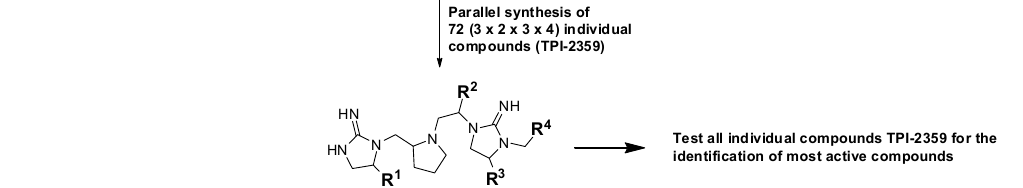
Figure 2. Deconvolution of positional scanning pyrrolidine bis ‐ cyclic guanidine library TPI ‐ 1955 and synthesis of individual compounds TPI ‐ 2359.